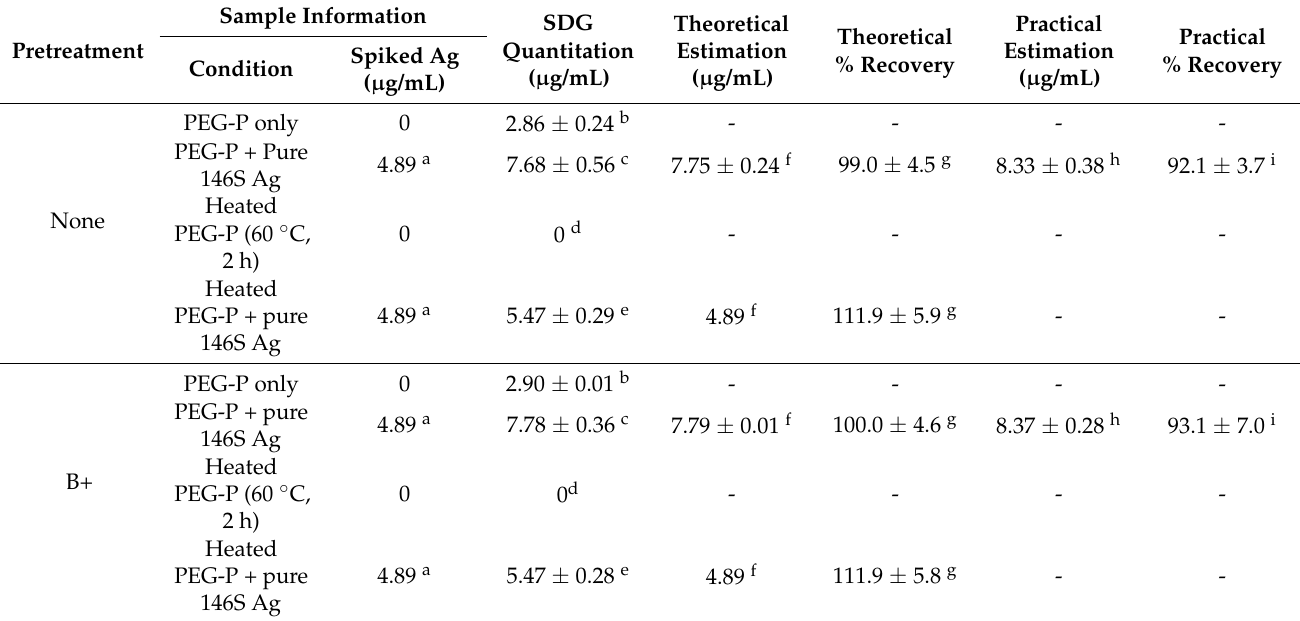
Table 3. A spiking test result by SDG ultracentrifugation for the validation of the pretreatment method for PEG-P.